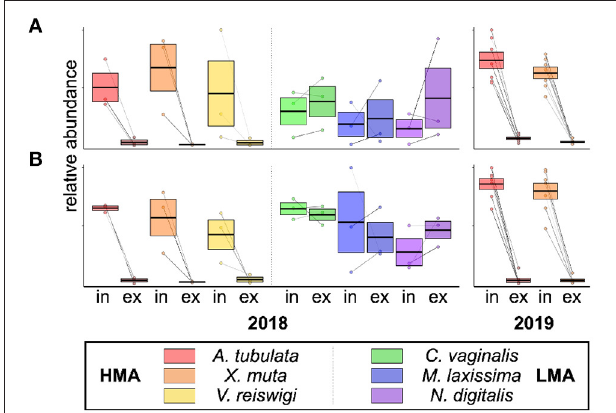
FIGURE 3 | Relative abundances of two of the 15 features that were significantly excurrent-depleted by HMA species and present in samples from both 2018 ( n = 3 species − 1 ) and 2019 ( n = 7 species − 1 ). Box-plots show the median ± 95% CI for incurrent and excurrent samples of each species, with lines connecting the incurrent and excurrent samples from the same individual. Shown are abundances of feature IDs (A) 12 and (B) 5, and IDs correspond to the rows in Supplementary Table 2 . For box-plots of all 15 features, see Supplementary Figure 3